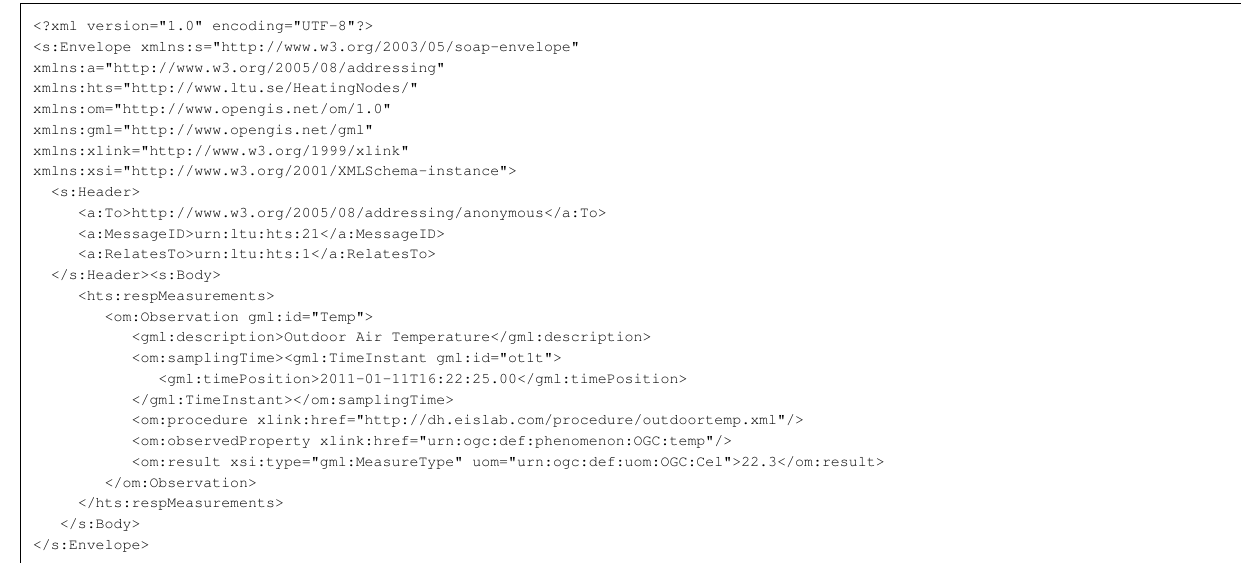
Figure 5. SOAP service response message in XML text format. EXI-encoded total size: 651